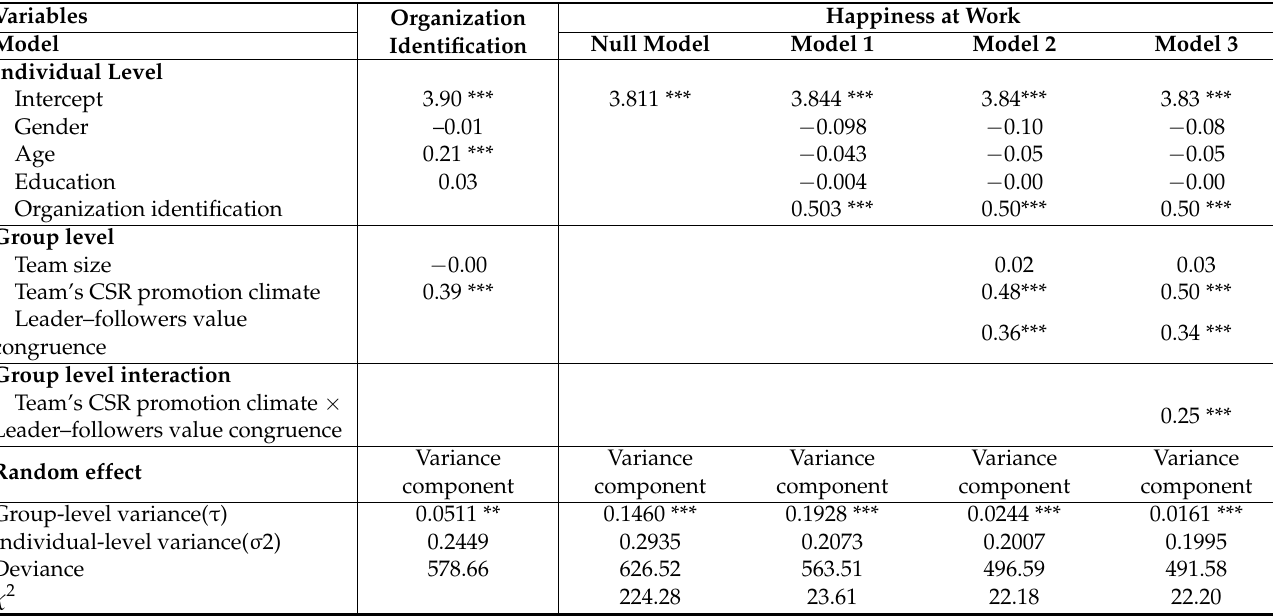
Table 4. Hierarchical linear model predicting: direct, mediating, and moderating